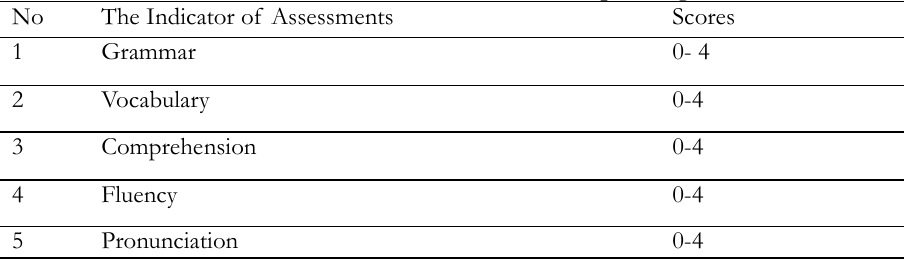
TABLE 1 . The criterion of speaking scores